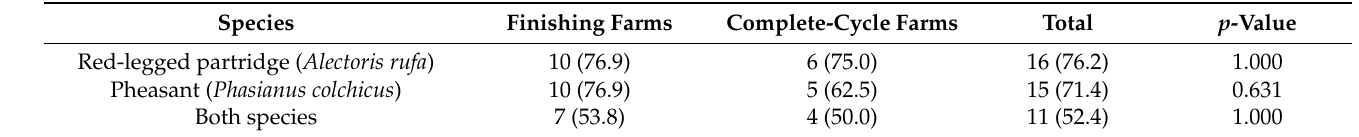
Table 5. Frequency (n, and % between parentheses) of farms that produced game species other than quail (n = 21).